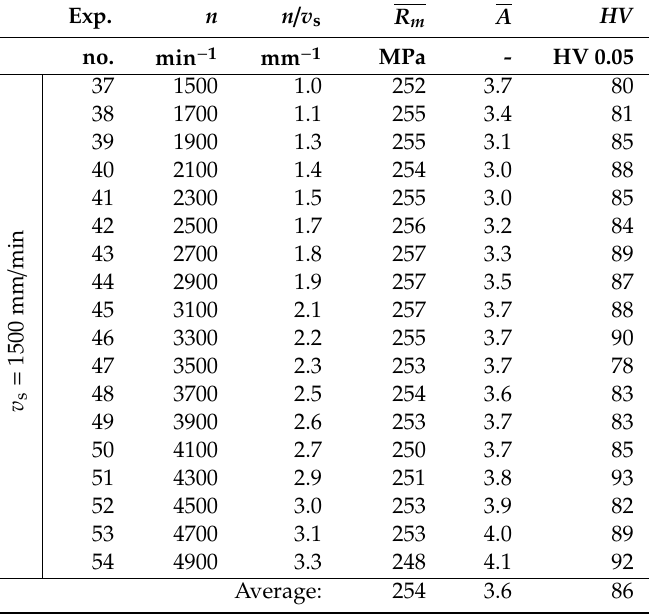
Table A3. Welding experiments performed and mechanical properties achieved for a welding speed v s of 1500 mm / min.